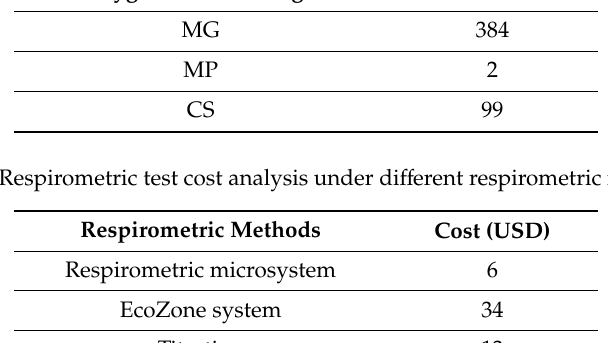
Table 1. Oxygen sensor cost analysis under different designs.